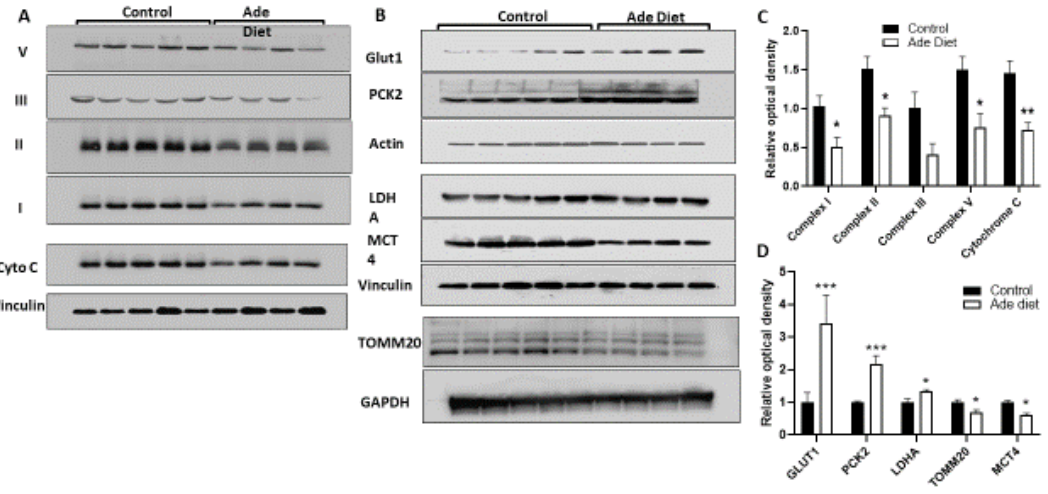
Figure 4. OXPHOS profile of gastrocnemius muscle from CKD mice compared to controls. ( A ) OXPHOS profile and cytochrome C were evaluated by Western blot analysis on gastrocnemius muscle of